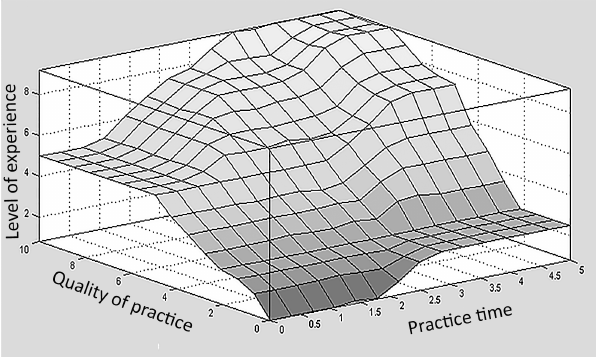
Fig 4. Surface graph representation of the levels of running experience in relation to quality of practice and practice time.